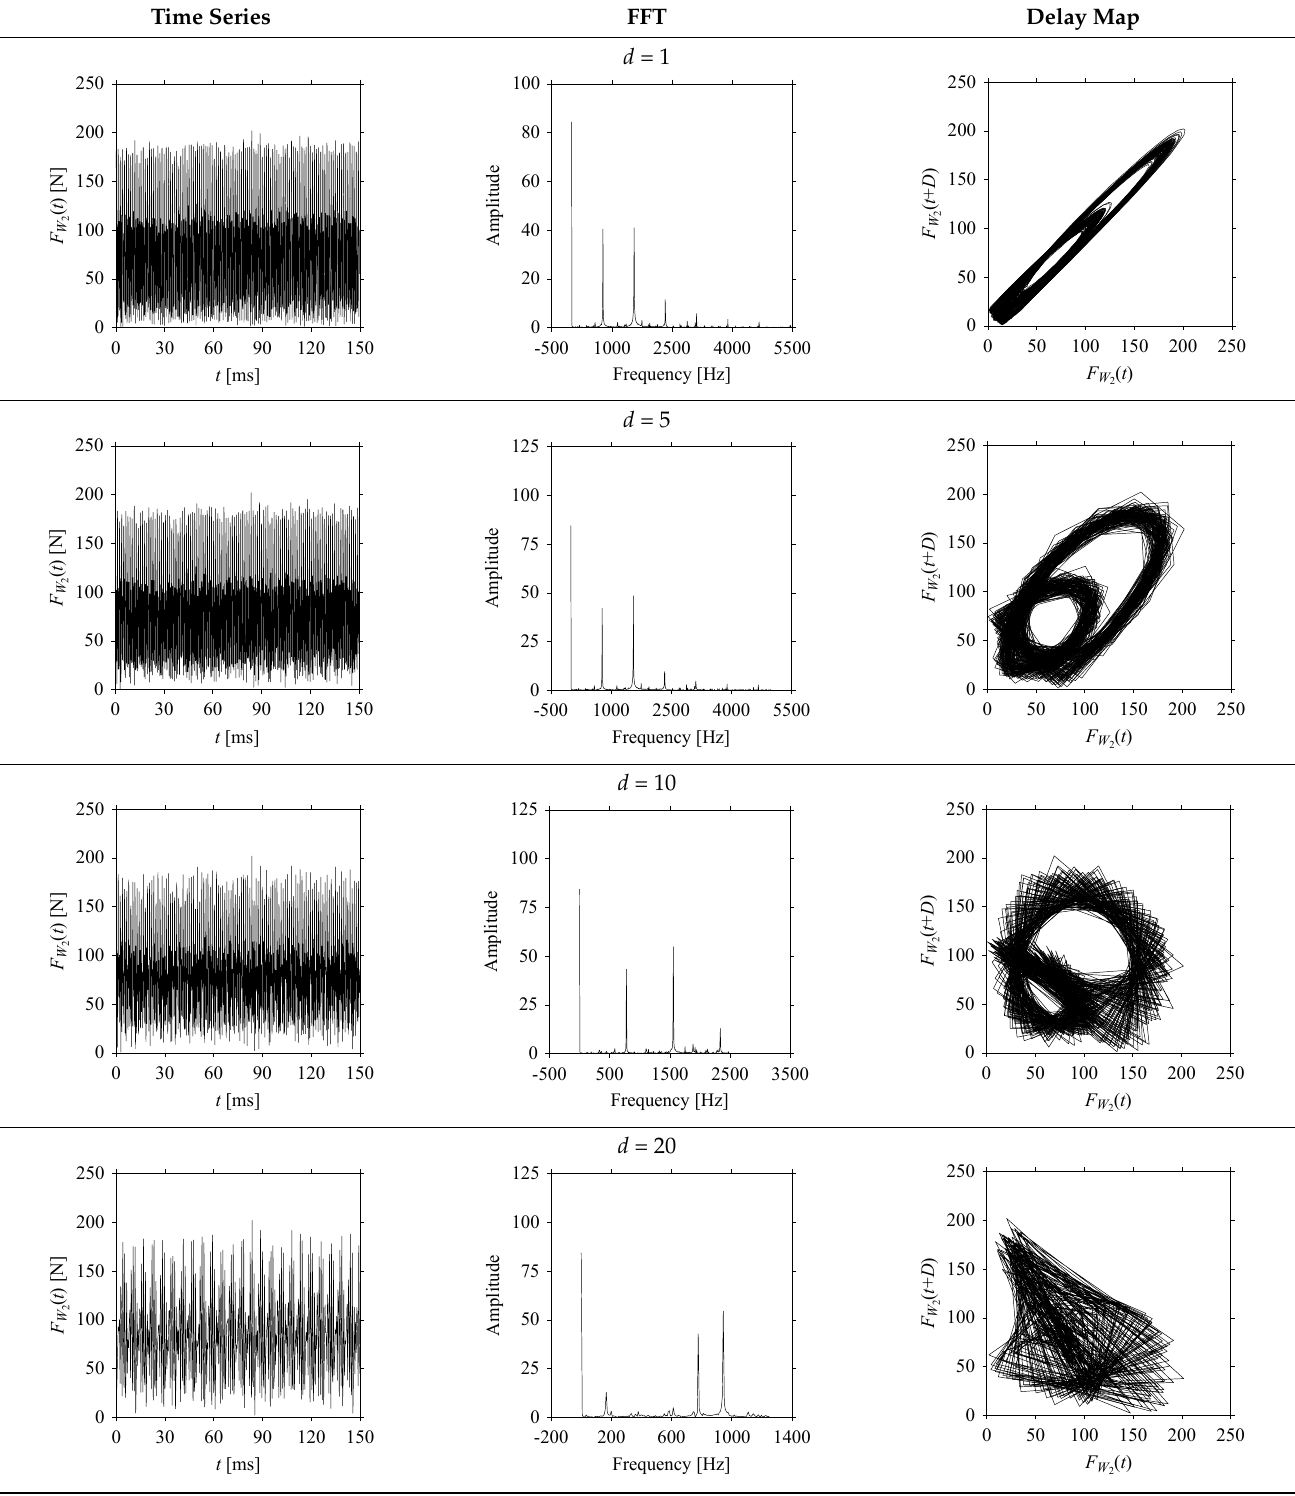
Table A1. F W in the form of time series, FFT, and delay map under varying delay ( d ).